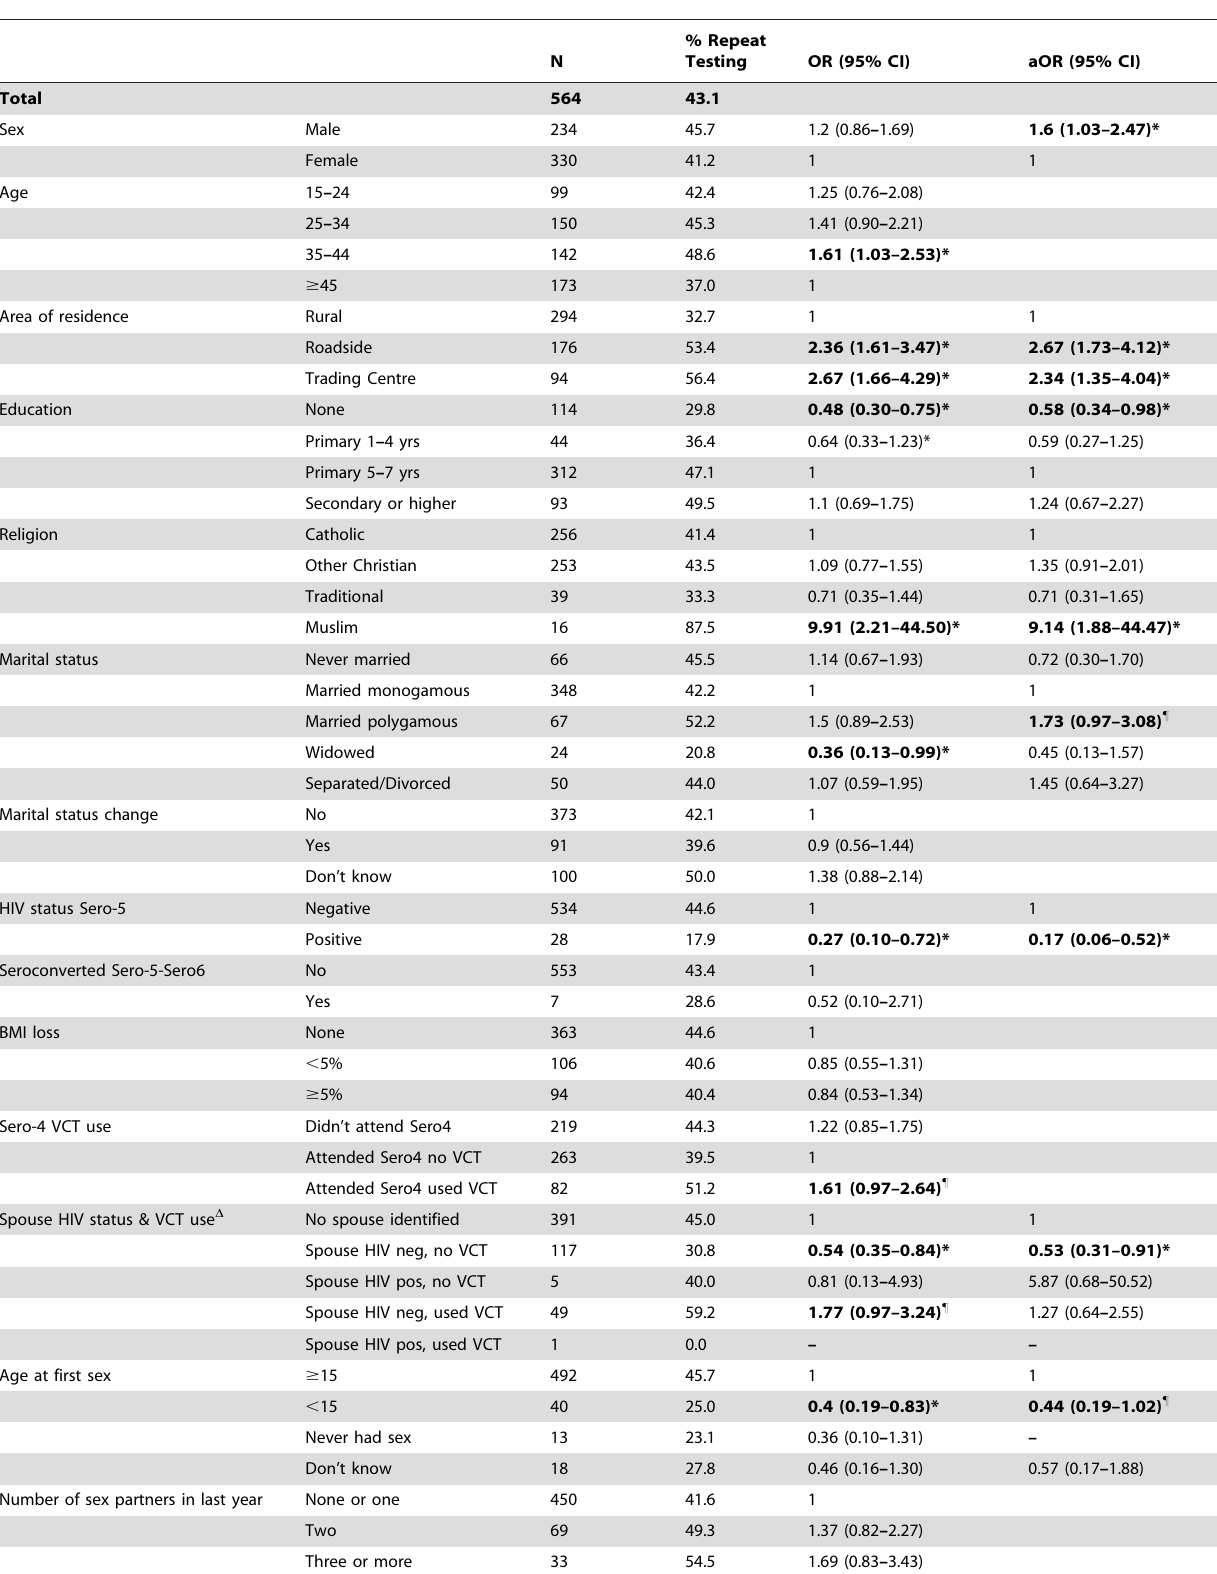
Table 5. Characteristics of individuals attending both Sero-5 and Sero-6 and factors associated with repeat use of VCT at each round #